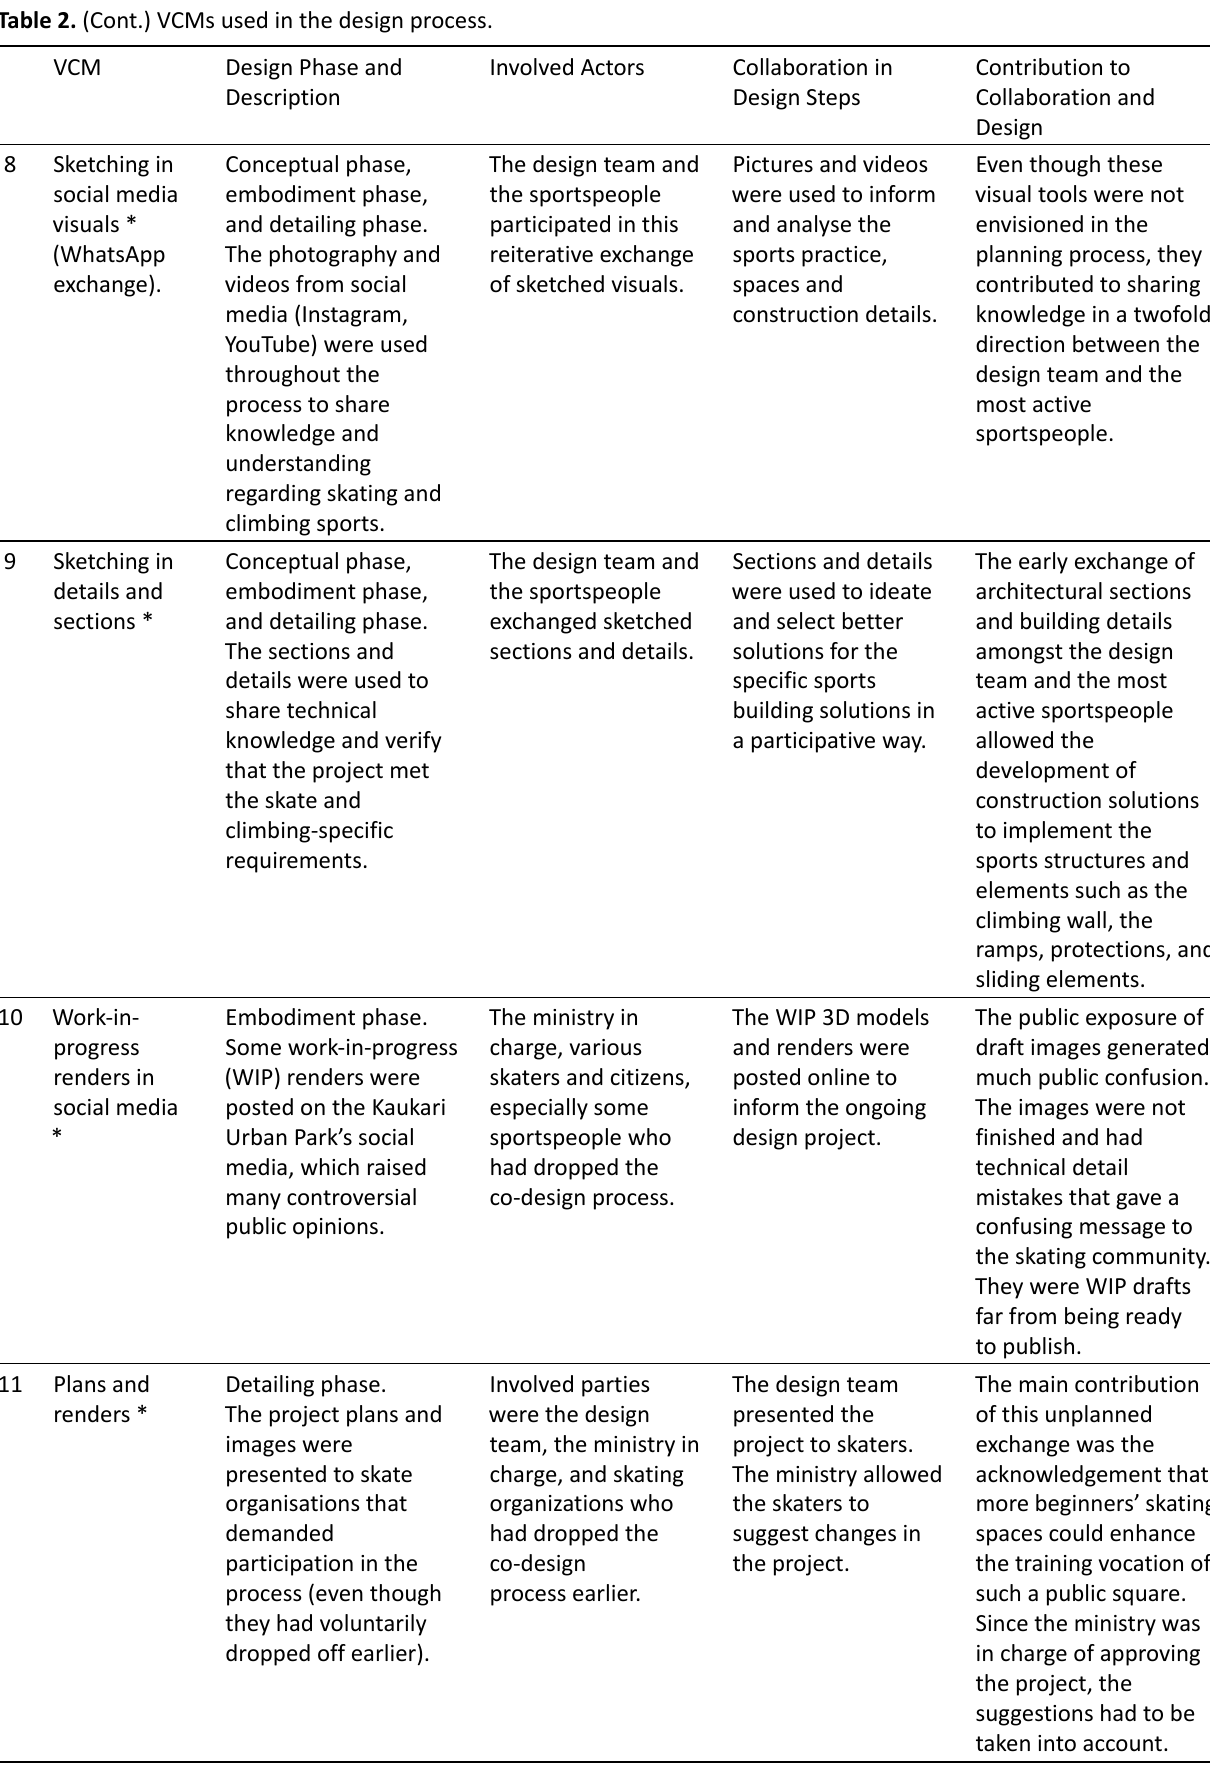
Table 2. (Cont.) VCMs used in the design